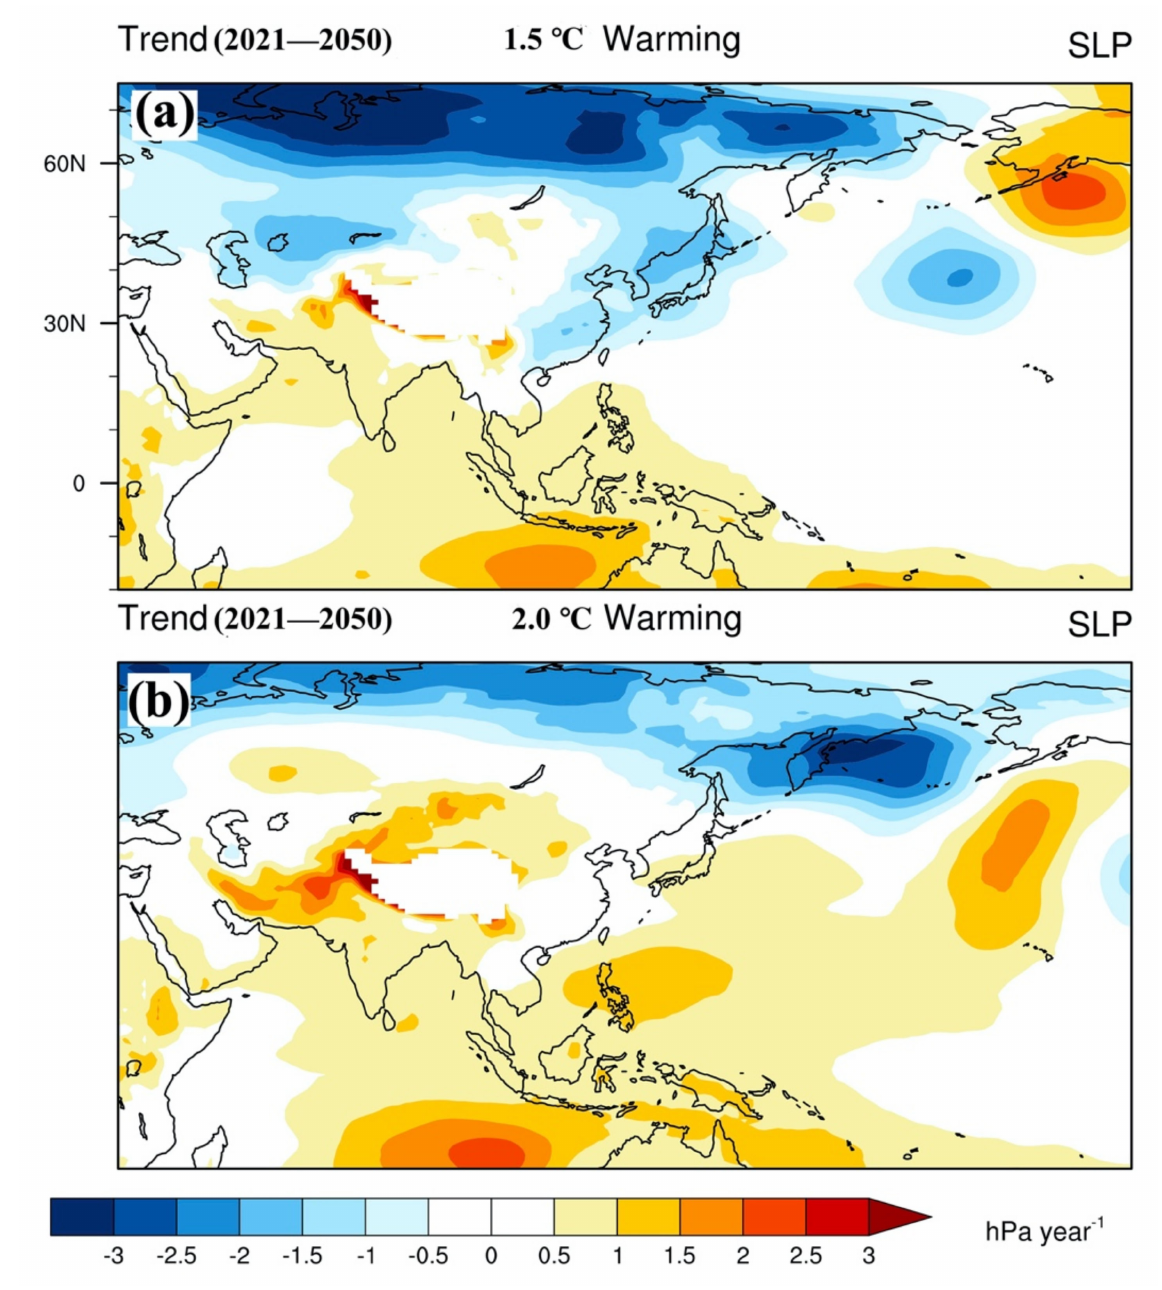
Figure 4. Ensemble JJAS trend (2021–2050) of SLP (hPa/year) under ( a ) 1.5 ◦ C and ( b ) 2.0 ◦ C warming